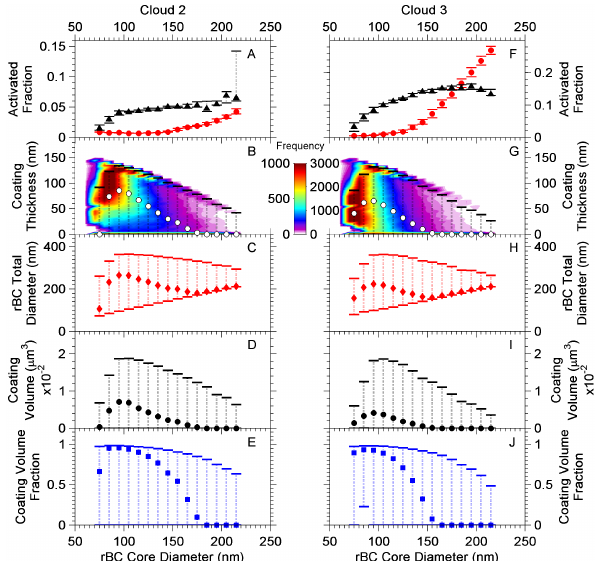
Figure 6. Shown in (a) and (f) are the median size-dependent ac- tivated fraction (AF) for the aerosol (red circles), and rBC (black triangles) for Clouds 2 and 3, respectively, where the error bars rep- resent the 10th and 90th percentiles. The bottom axes represent par- ticle diameter for the aerosol and core diameter for rBC. Panels (b) and (g) show a 2-D histogram of coating thickness with the median values (white circles) overlaid on top, where the error bars show the 10th and 90th percentiles. Panels (c) and (h) show rBC total diam- eter (i.e., the core and the coating), (d) and (i) the coating volume, and (e) and (j) the coating volume fraction, all as a function of rBC core